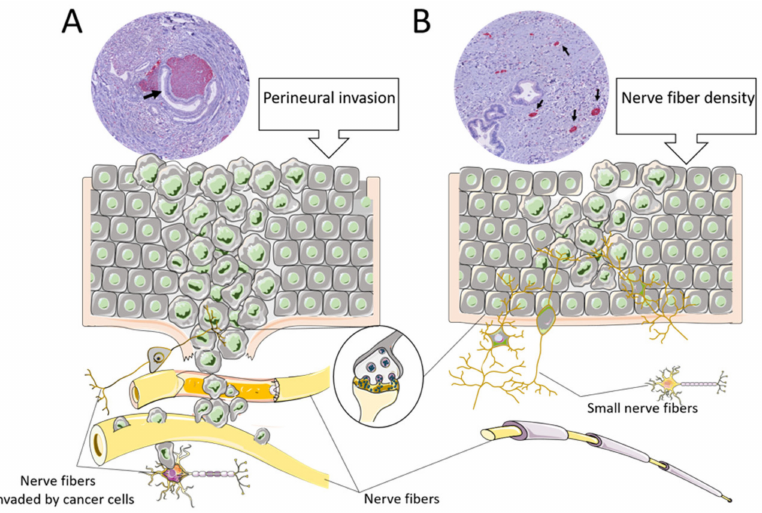
Figure 2. The difference between nerve fiber density and perineural invasion (PNI). ( A ): Graphical overview of perineural invasion. The cancer cells invade the endoneurial or epineurial sheeth of a larger nerve fiber. The immunohistochemical PGP9.5 staining illustrates the nerve fiber with cancer tissue around it. ( B ): Graphical overview of nerve fiber density. The small nerve fibers grow in the tumor microenvironment but are usually not invaded by cancer cells. The immunohistochemical PGP9.5 staining shows small positive (red)